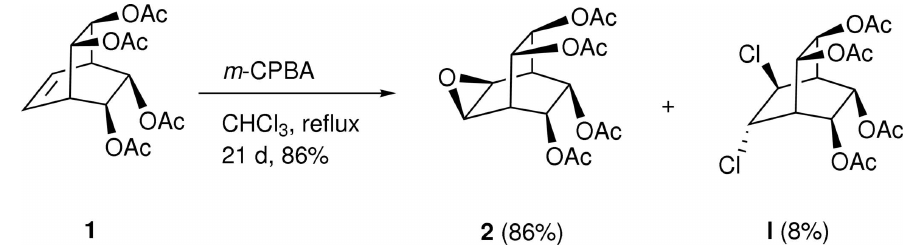
An ORTEP - 3 (Farrugia, 1997) drawing of the title molecule with the atom-numbering scheme. The displacement ellipsoids are drawn at the 50% probability level.